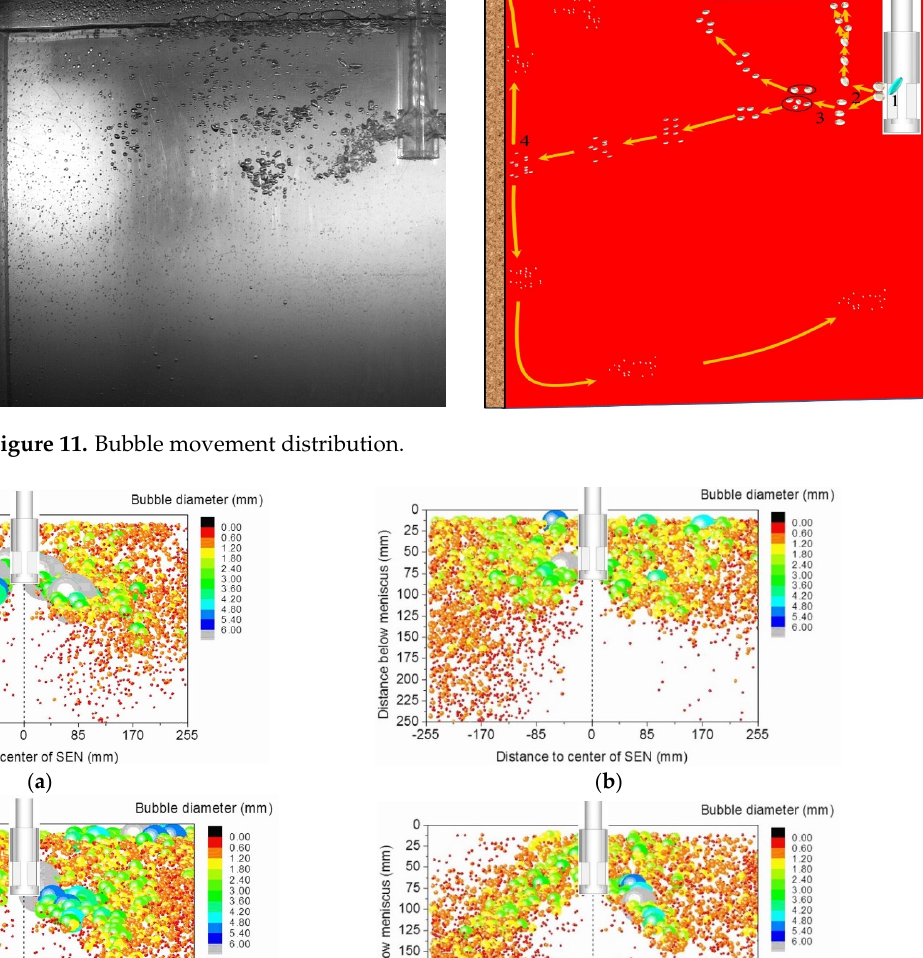
Figure 11. Bubble movement distribution.